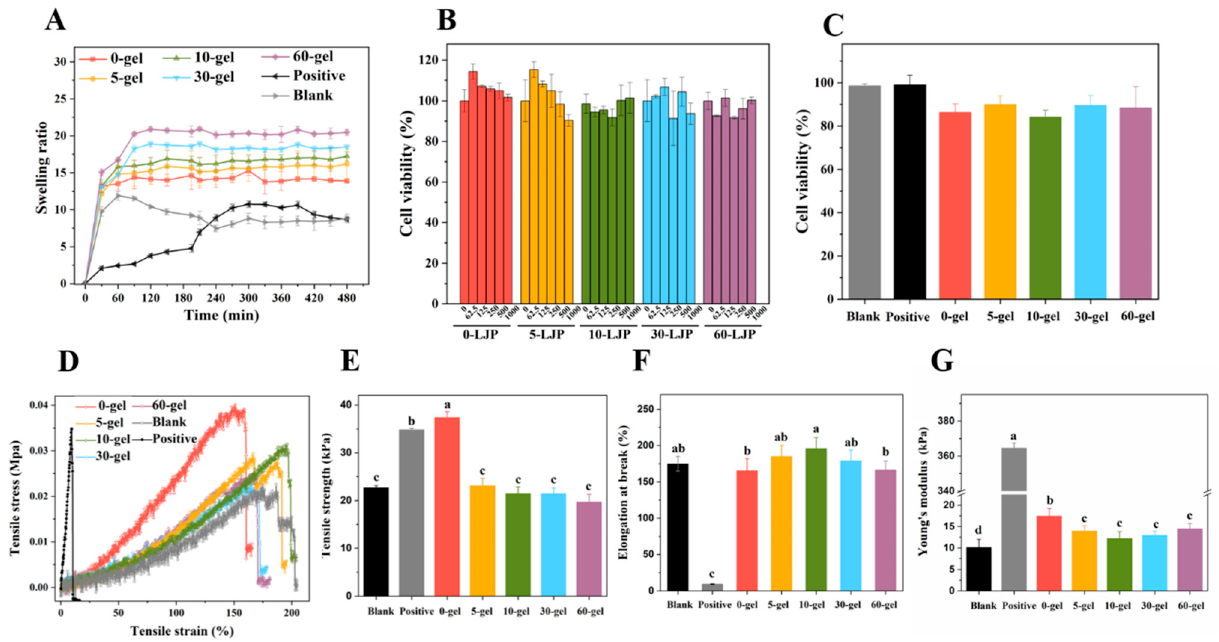
Figure 2. The swelling properties of LJP-based hydrogels ( A ). The cell viabilities of LJP ( B ) and LJP-based hydrogels ( C ). The stress-strain curves ( D ), tensile strength ( E ), elongation at break ( F ), and Young’s modulus ( G ) of LJP-based hydrogels. a–d Values with different letters are significantly different ( p < 0.05).